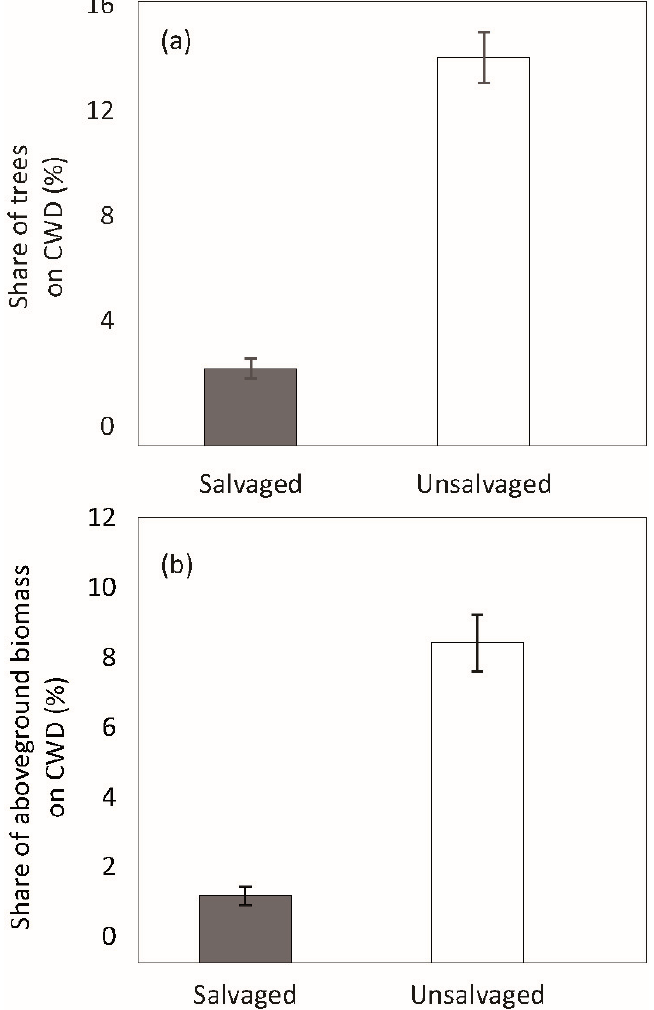
Figure 6. Share of trees growing on coarse woody debris (CWD) at salvaged and unsalvaged plots expressed from the number of trees ( a ) and aboveground biomass ( b ) (the High Tatra Mts. in 2019). Differences were tested with an LSD test, which confirmed significant results in both cases ( p < 0.001). Error bars show standard errors.